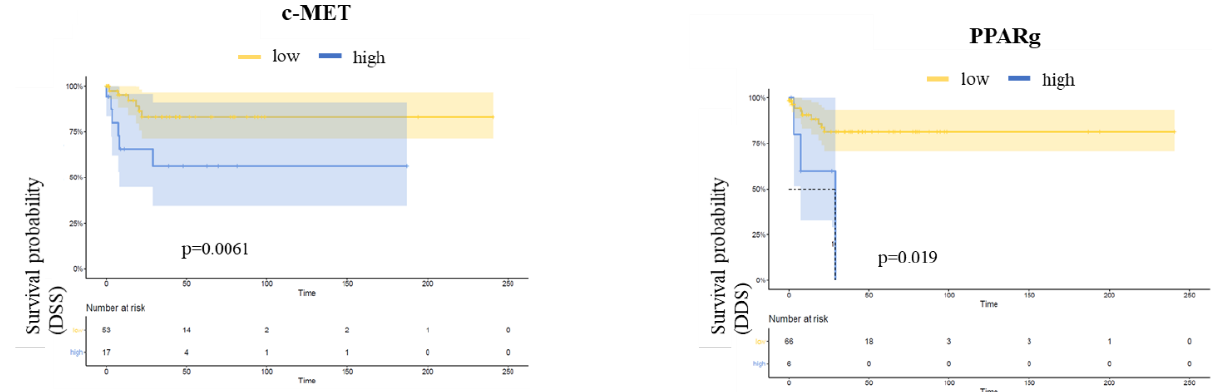
Figure 2. Kaplan – Meier plots of DSS according to c-MET and PPARg. Elevated biomarker expres- Figure 2. Kaplan–Meier plots of DSS according to c-MET and PPARg. Elevated biomarker expressions